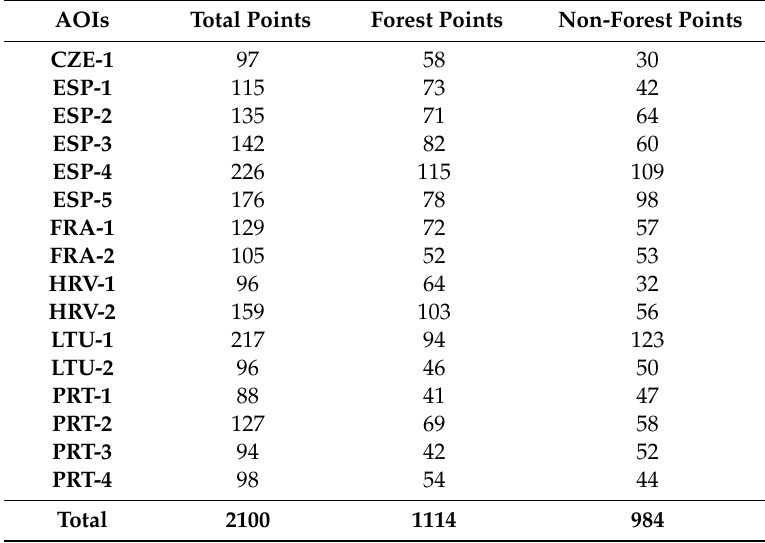
Table 2. Final distribution of points per AOI and